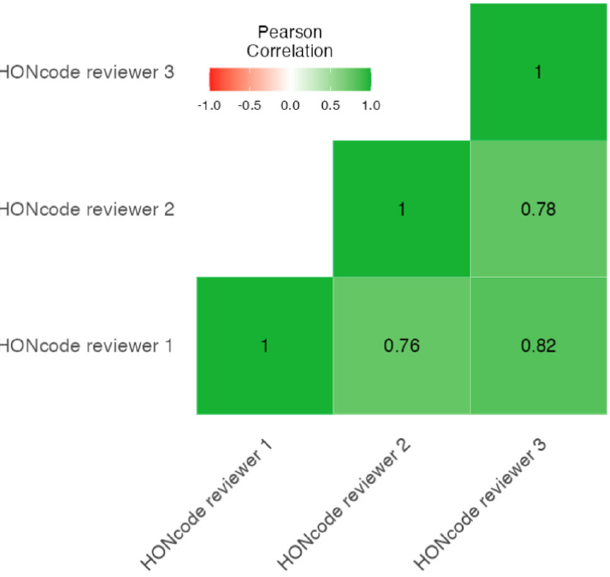
Figure 1. Heat map of the correlation between the HONcode scores of the three reviewers.